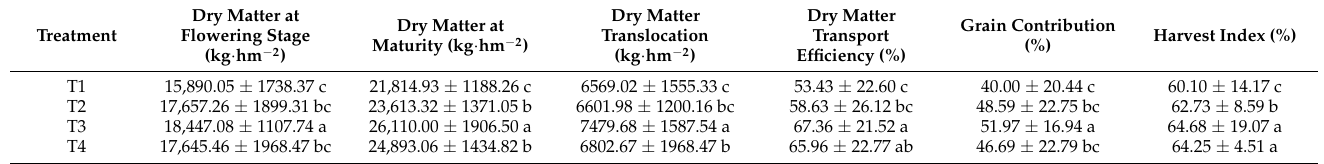
Table 6. Effect on harvest index of maize under different irrigation